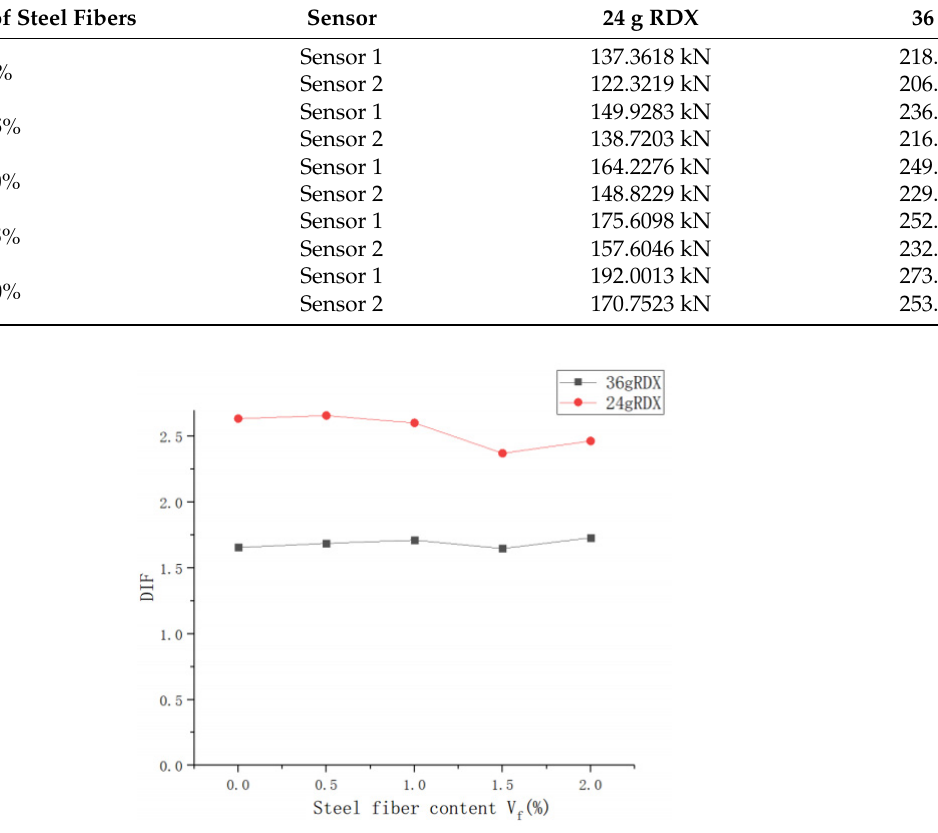
Figure 8. Dynamical enhancement factor.